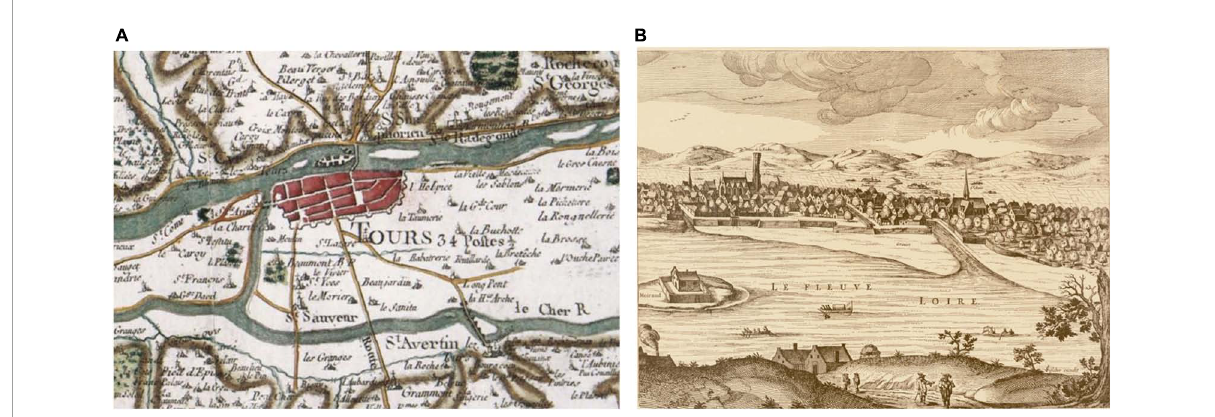
FIGURE16 (A) Cassini’s map of Tours (1770) showing the Saint-Anne canal in the West of the city (Géoportail, 2020). (B) Engraving showing the confluence of the Saint-Anne canal with the Loire (Tours